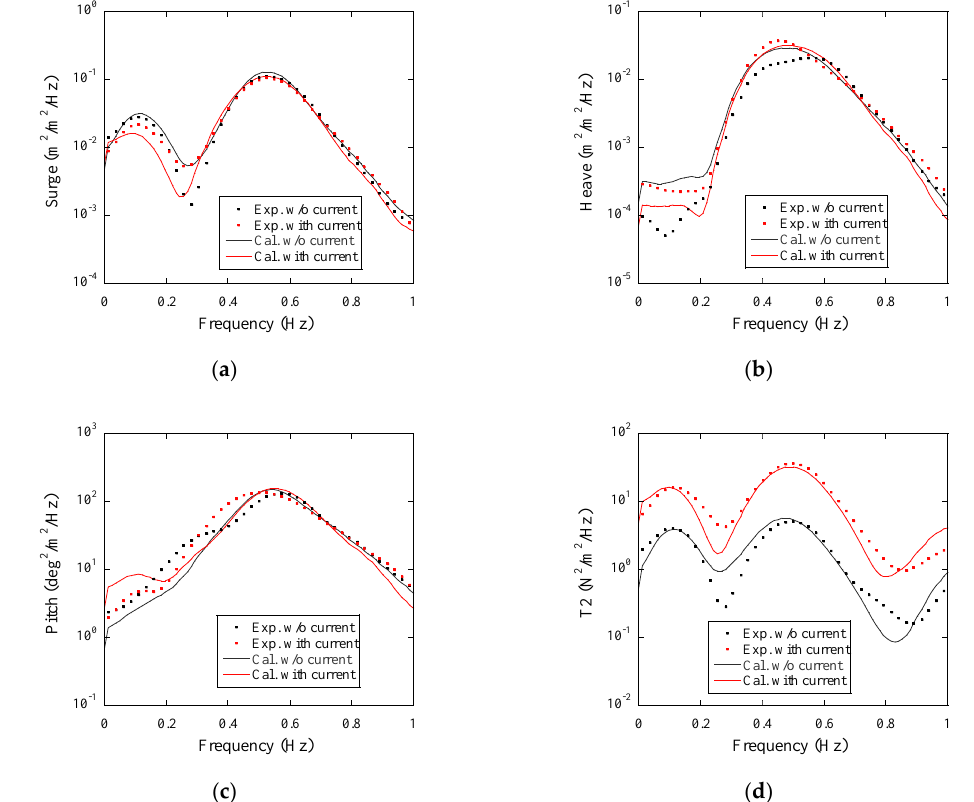
Figure 14. Comparison of predicted and measured PSD of motions and mooring tension in wave-only and combined wave-current conditions. ( a ) PSD of surge motion, ( b ) PSD of heave motion, ( c ) PSD of pitch motion and ( d ) PSD of mooring tension.